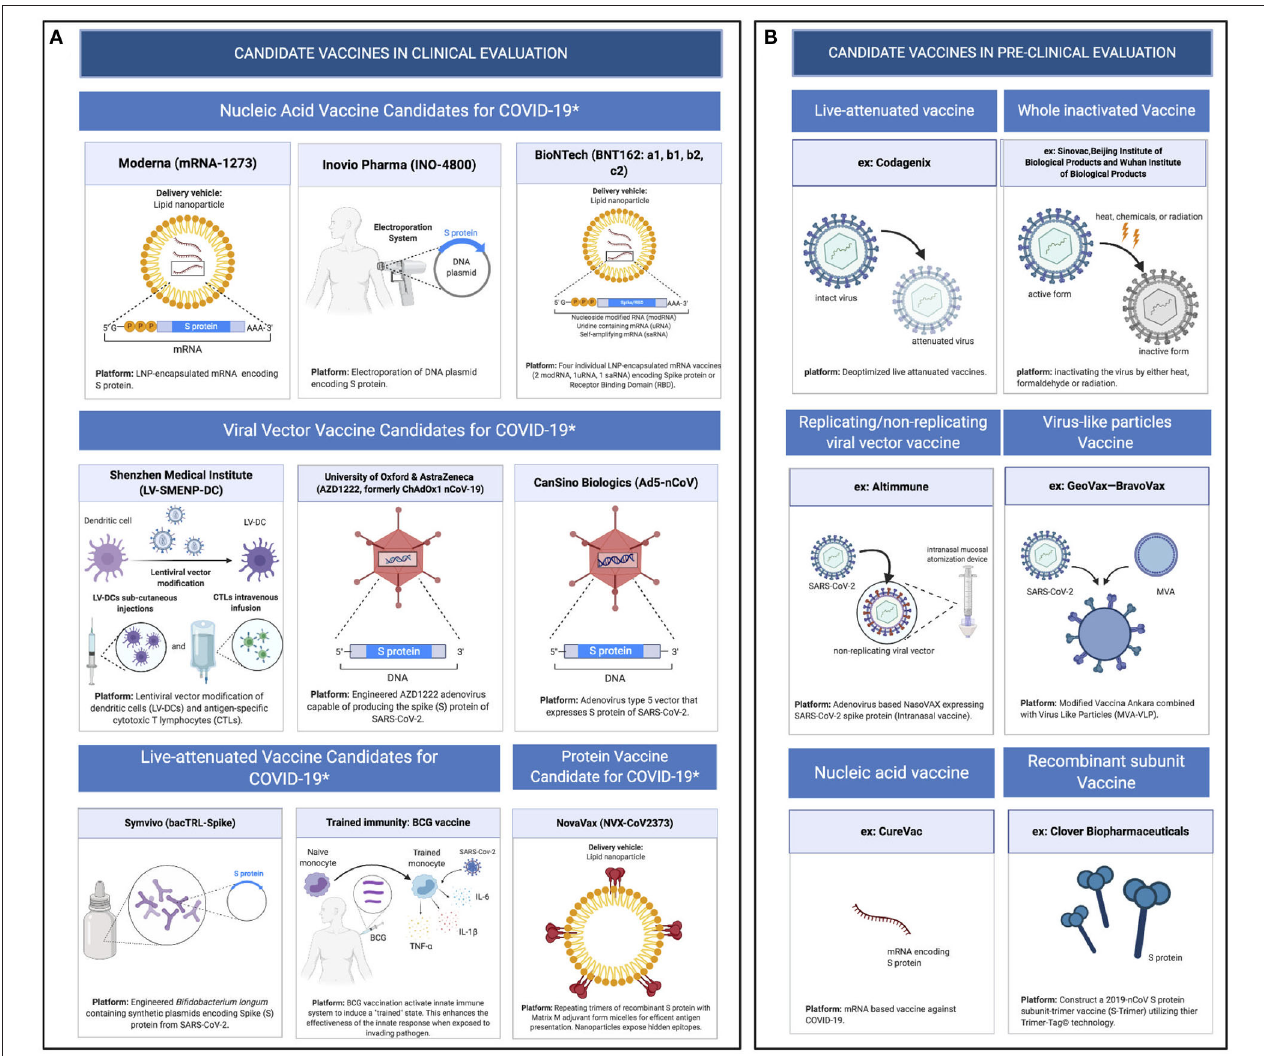
FIGURE 4 | Pipeline of COVID-19 vaccine candidates’ platforms. (A) Ongoing vaccine development platforms for SARS-CoV-2 (live attenuated, nucleic acid, viral vector, and protein vaccines). (B) Pre-clinical vaccine candidates’ platforms (live attenuated virus, inactivated virus, replicating/non-replicating viral vector, virus like particles, subunit, and nucleic acid